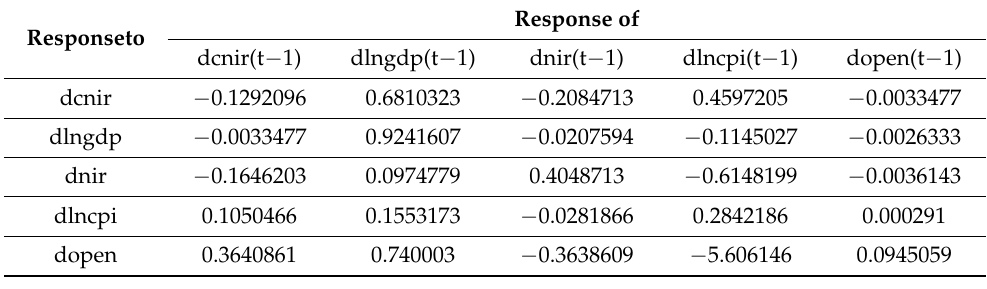
Table 9. Generalised Method of Moments (GMM) Panel Vector Autoregression Model for Interest Rate Shock.